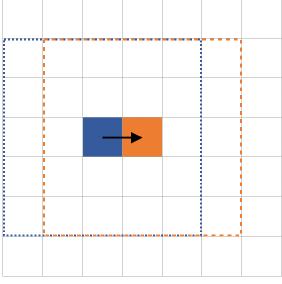
Figure 4. Reference pixel path during an iteration with a kernel size of 2, one painted in blue and another painted in orange.